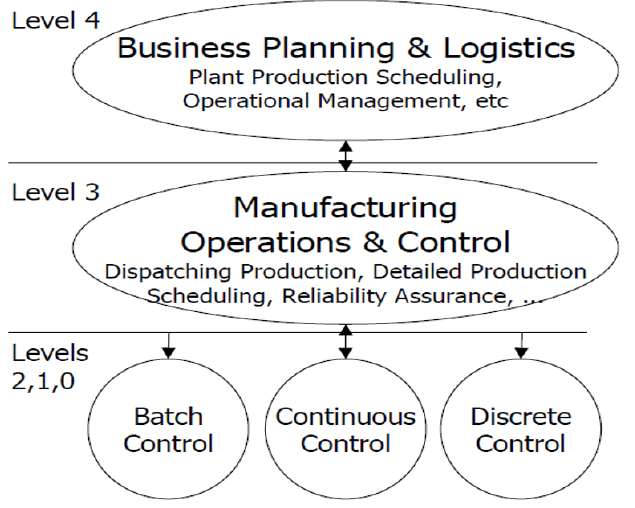
Figure 2. Functional hierarchy of production as specified in ISA-95.